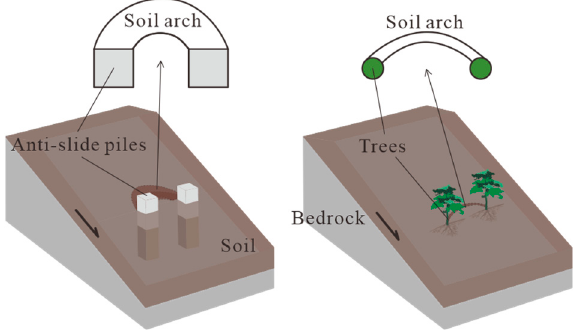
Figure 14. Schematic diagram of soil arch under anti-slide piles and tree root systems.